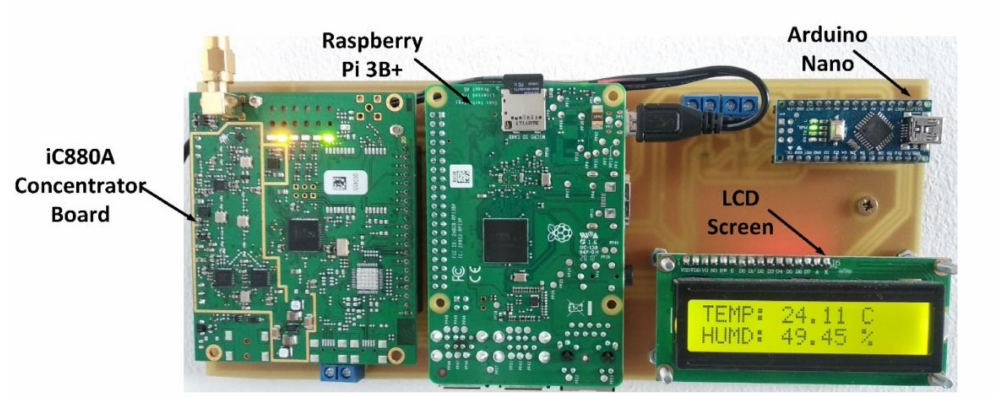
Figure 9. LoRaWAN gateway. The gateway integrates a Raspberry PI 3B + and the iC880A concentrator that allows the simultaneous communication on eight channels (as stated in the LoRaWAN specifications).